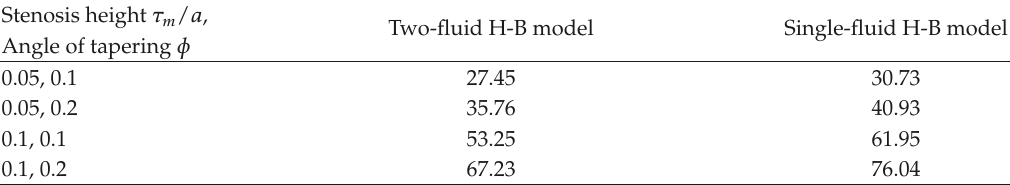
Table 3: Percentage of increase in longitudinal impedance due to the e ff ect of both the angle of tapering and stenosis height for the two-fluid H-B model and single-fluid H-B model with α (cid:7) 0.95, μ H (cid:7) 0.035, μ N (cid:7) 0.3 μ (cid:7) H , and τ y